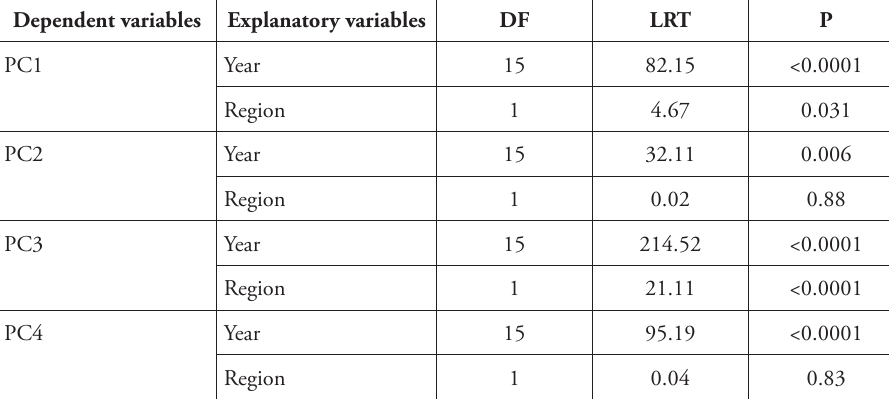
Table 2. Results of the General Linear Mixed Models (GLMMs) testing for differences between years and regions (coastal vs. interior-mountain) in weather variables (PC1, PC2, PC3, and PC4; see Table 1). The “weather station” identity was included as a random effect to take into account for the non-independence of data from the same locality. DF: Degree of Freedom, LRT: Likelihood Ratio